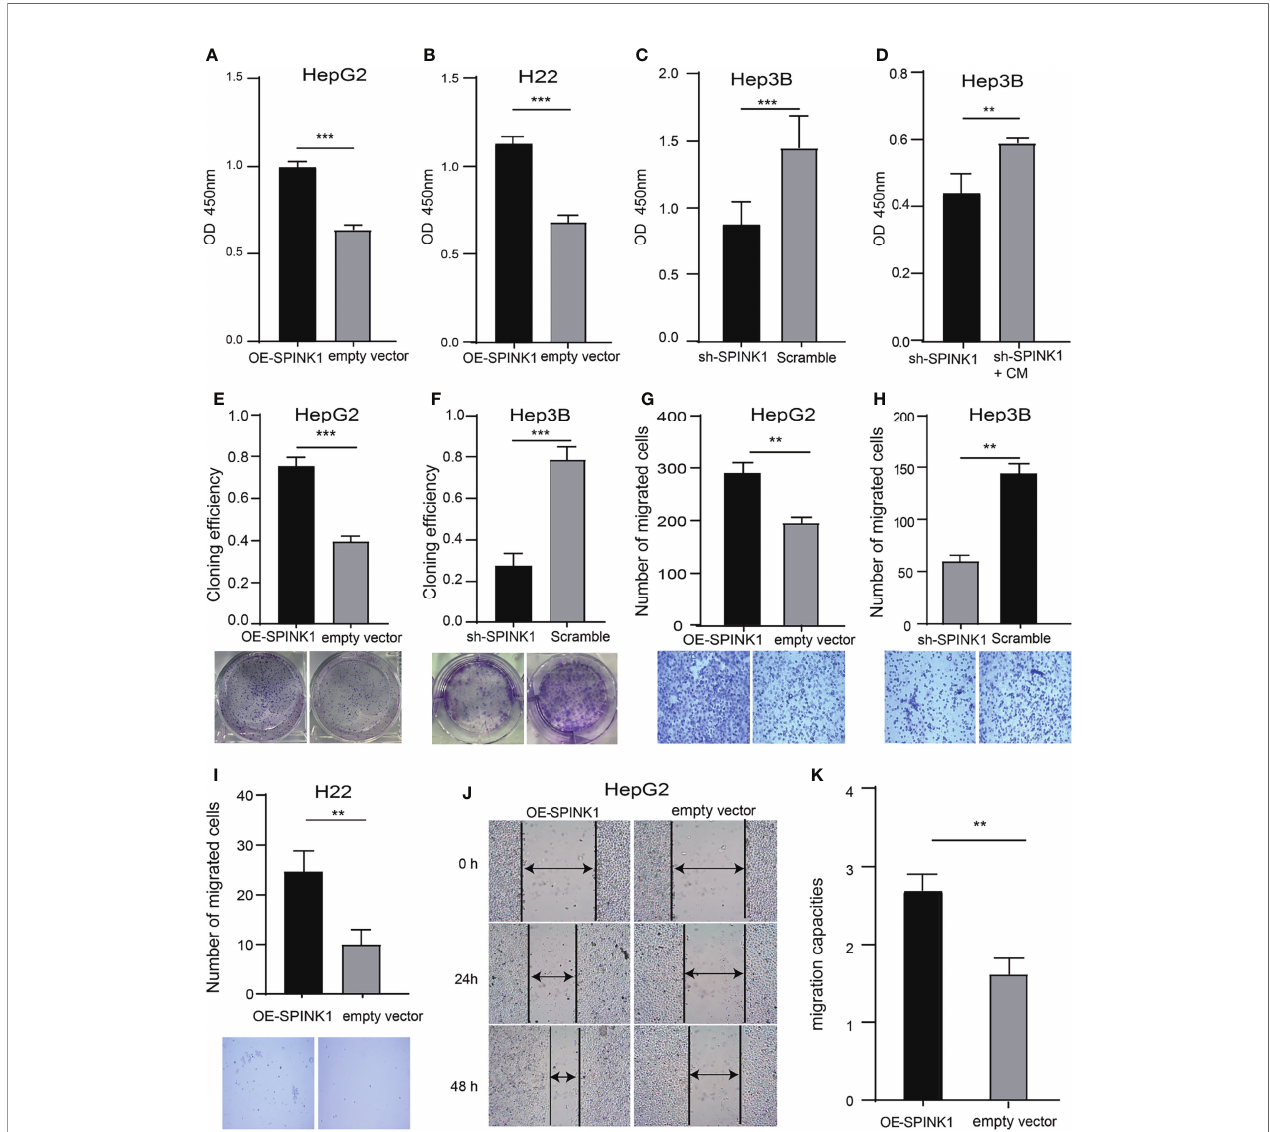
FIGURE 5 | SPINK1 ’ s regulation on proliferation, clonogenic formation and migration of SPINK1 -OE and SPINK1 -silencing HCC cells. (A, B) CCK-8 assays for metabolic and proliferative activities in stable SPINK1 -OE HepG2 and SPINK1 -OE H22 cells. (C, D) Proliferative capability and corresponding phenotype rescue after addition of conditioned medium (CM) for SPINK1 -silencing Hep3B cells. (E, F) Clonogenic formation in SPINK1 -OE HepG2 and knockdown Hep3B HCC cells, along with images of formed clones following inoculation of corresponding SPINK1 -OE HepG2, SPINK1 -silencing H3B and control cells for two weeks. (G – I) Transwell assays for SPINK1 -OE HepG2, SPINK1 -OE H22 and SPINK1 knockdown Hep3B cells, with photos that showed cells passing through well ’ s pores both in control and experimental groups, respectively. (J, K) Images and bar chart for measurement of migration distances of SPINK1 -OE HepG2 cells 24 and 48 hrs post- scratching in Wound-healing assay (Scratch test). Error bars represent mean ± standard deviation of independent experiments or the experiments performed in triplicates either in 6-well or 96-well plates. OD, optical density; **, P < 0.01; ***, P <